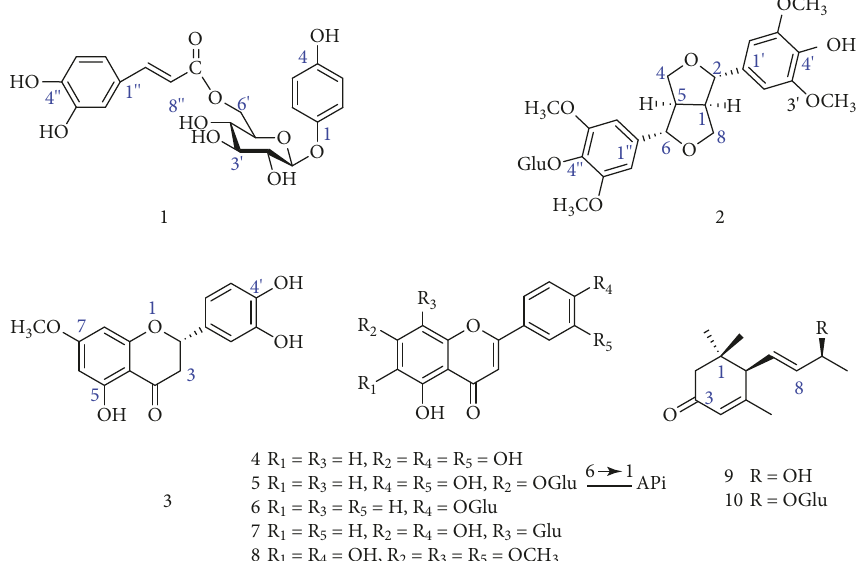
Figure 1: Structures of compounds 1 – 10 isolated from O. majorana